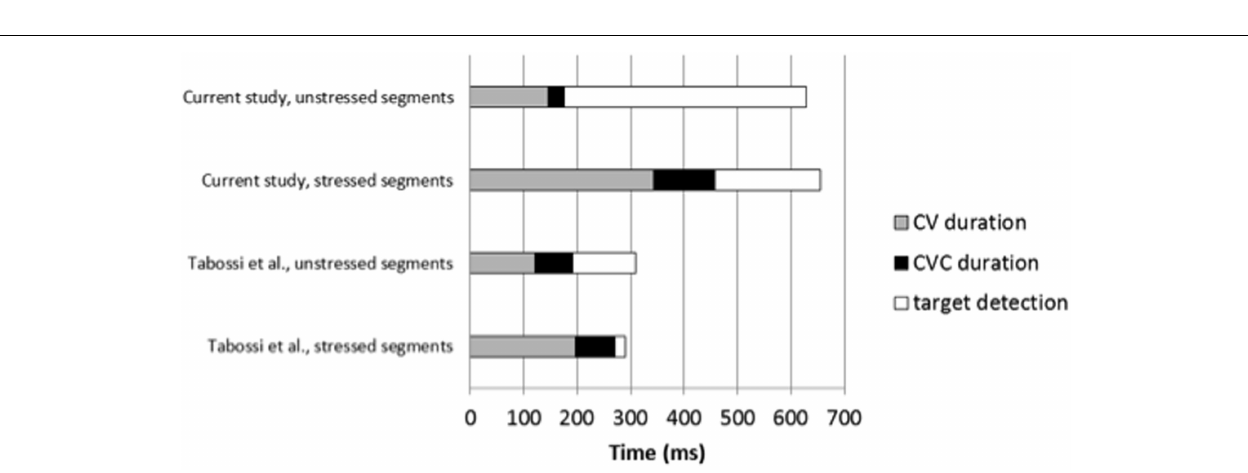
correspond to the duration of the additional C (gray + black = duration of the CVC portions). White bars correspond to the cumulative mean reaction times for target detection (CV and CVC combined) in these carriers (gray + black + white = total RT).